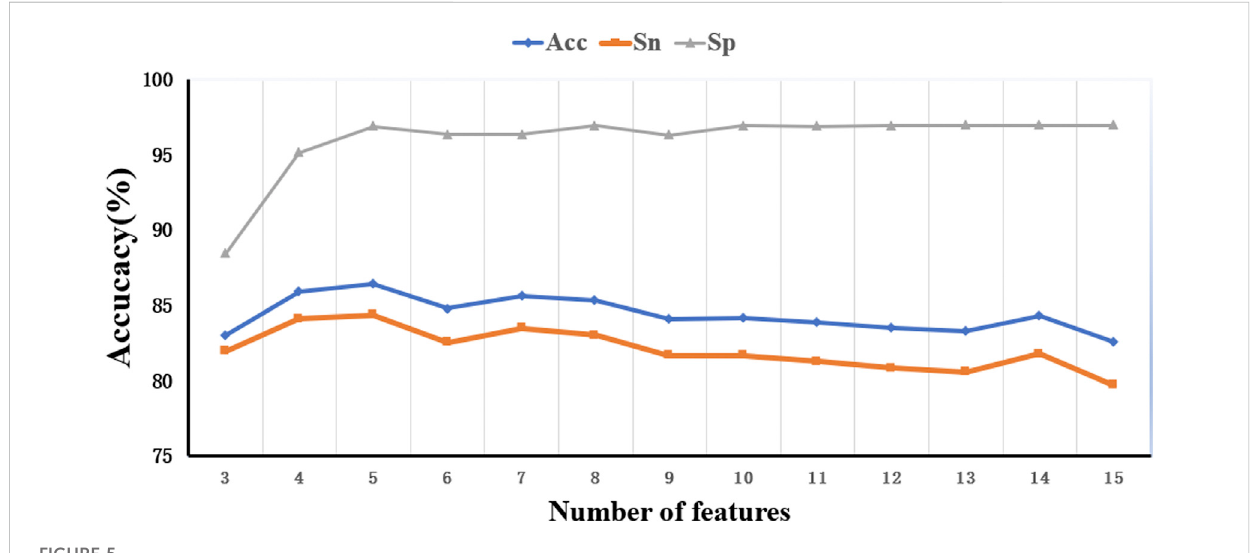
FIGURE 5 Trend of model performance under different quantitative characteristics.